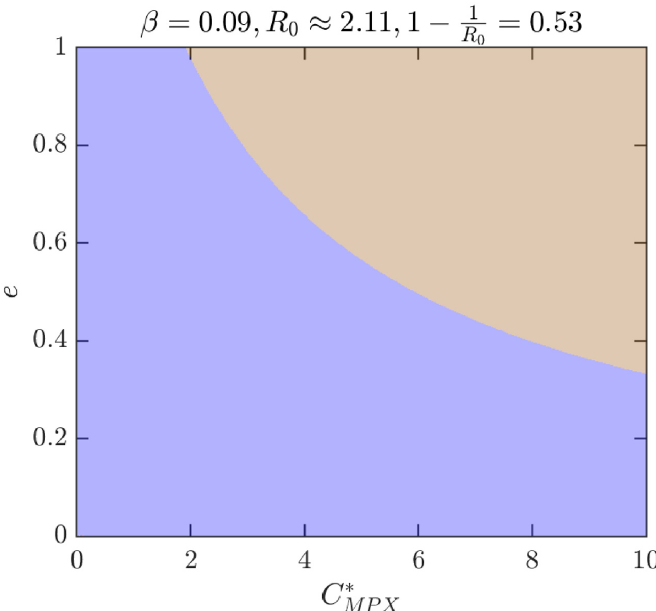
Fig 9. Nash equilibria as e and C � and it is CSNE. Unless varied or otherwise specified, the parameters are as in Table 1.